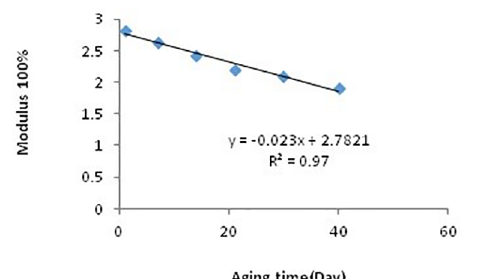
Figure 7. Stress Peak vs. Aging time